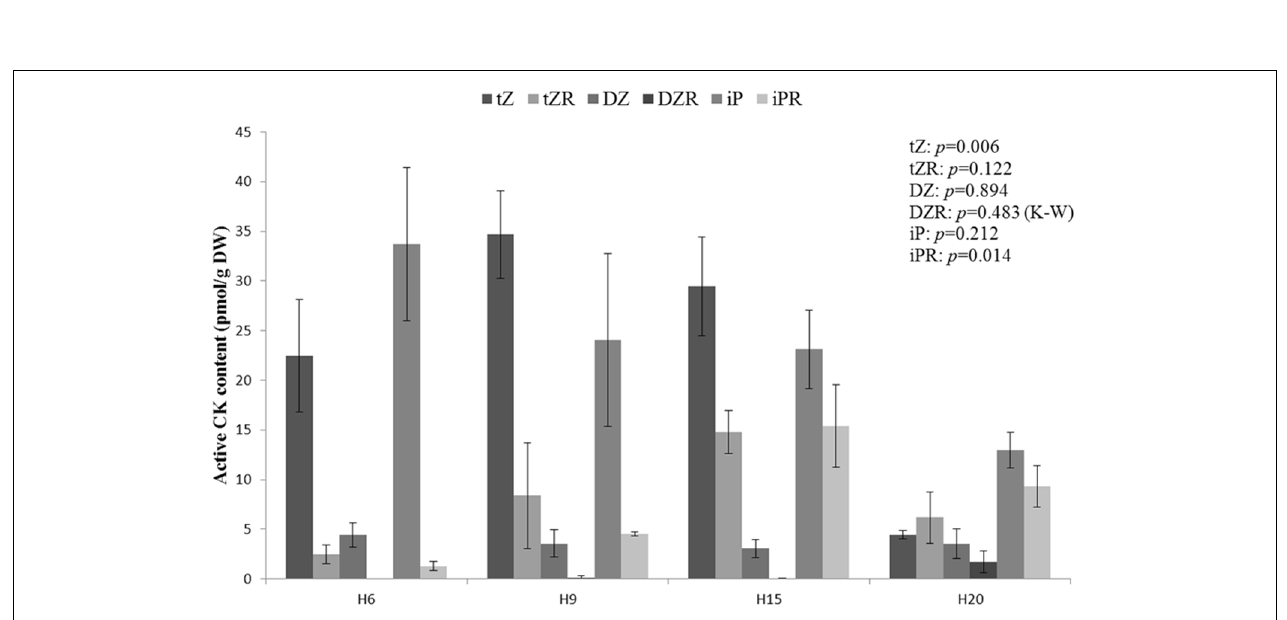
FIGURE 9 | Endogenous bioactive cytokinin levels in hemp hypocotyls at H6, H9, H15, and H20. tZ, trans -zeatin; tZR, trans -zeatin riboside; DZ, dihydrozeatin; DZR, dihydrozeatin riboside; iP N6-( (cid:49) 2-isopentenyl)adenine, iPR N6-( (cid:49) 2-isopentenyl)adenosine. ANOVA or Kruskal–Wallis (K–W) results are indicated depending on the normality of data distribution (Shapiro–Wilk p > 0.05 or p < 0.05, respectively). n = 3 biological replicates.